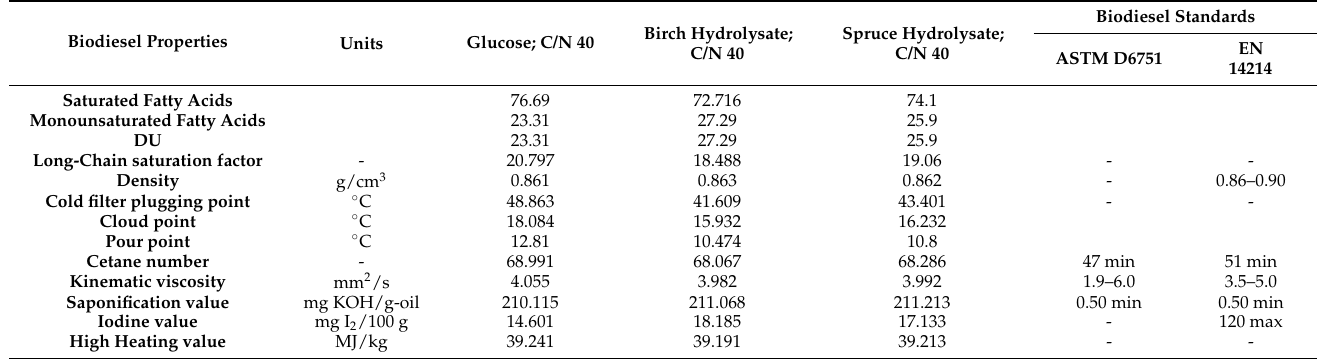
Table 4. Estimation of physicochemical properties of biodiesel obtained by cyanobacterial growth on glucose or